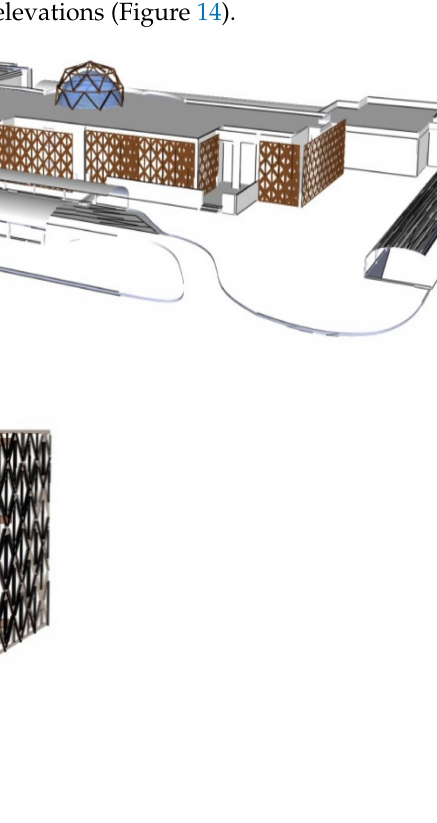
Figure 13. Parametric shading detail of retrofitted